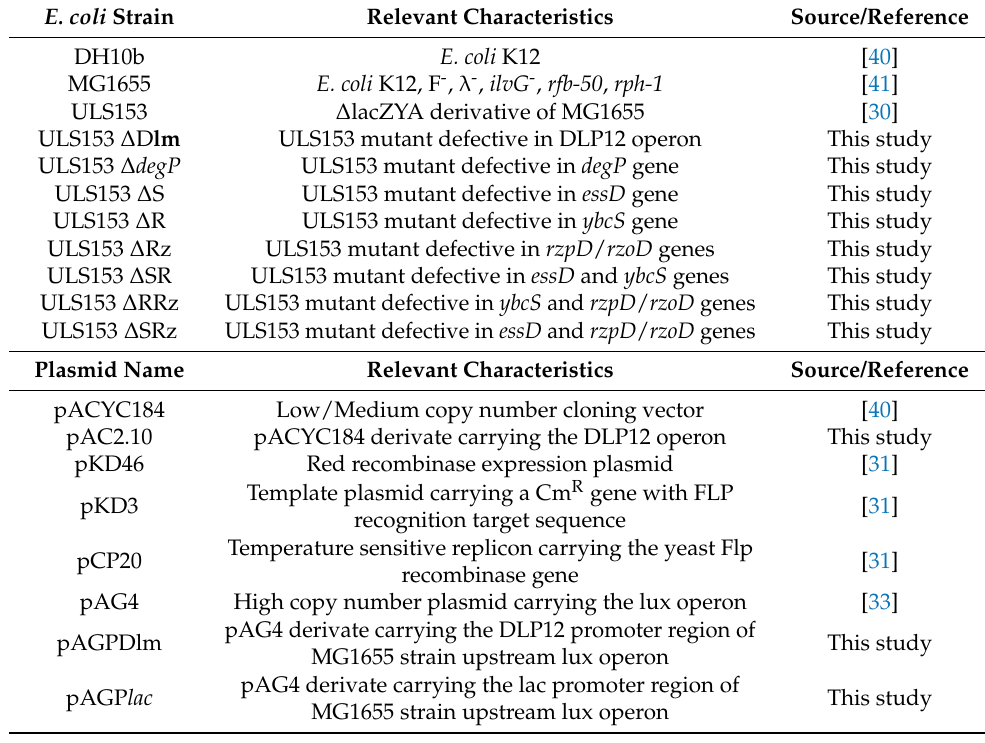
Table 1. Strains and